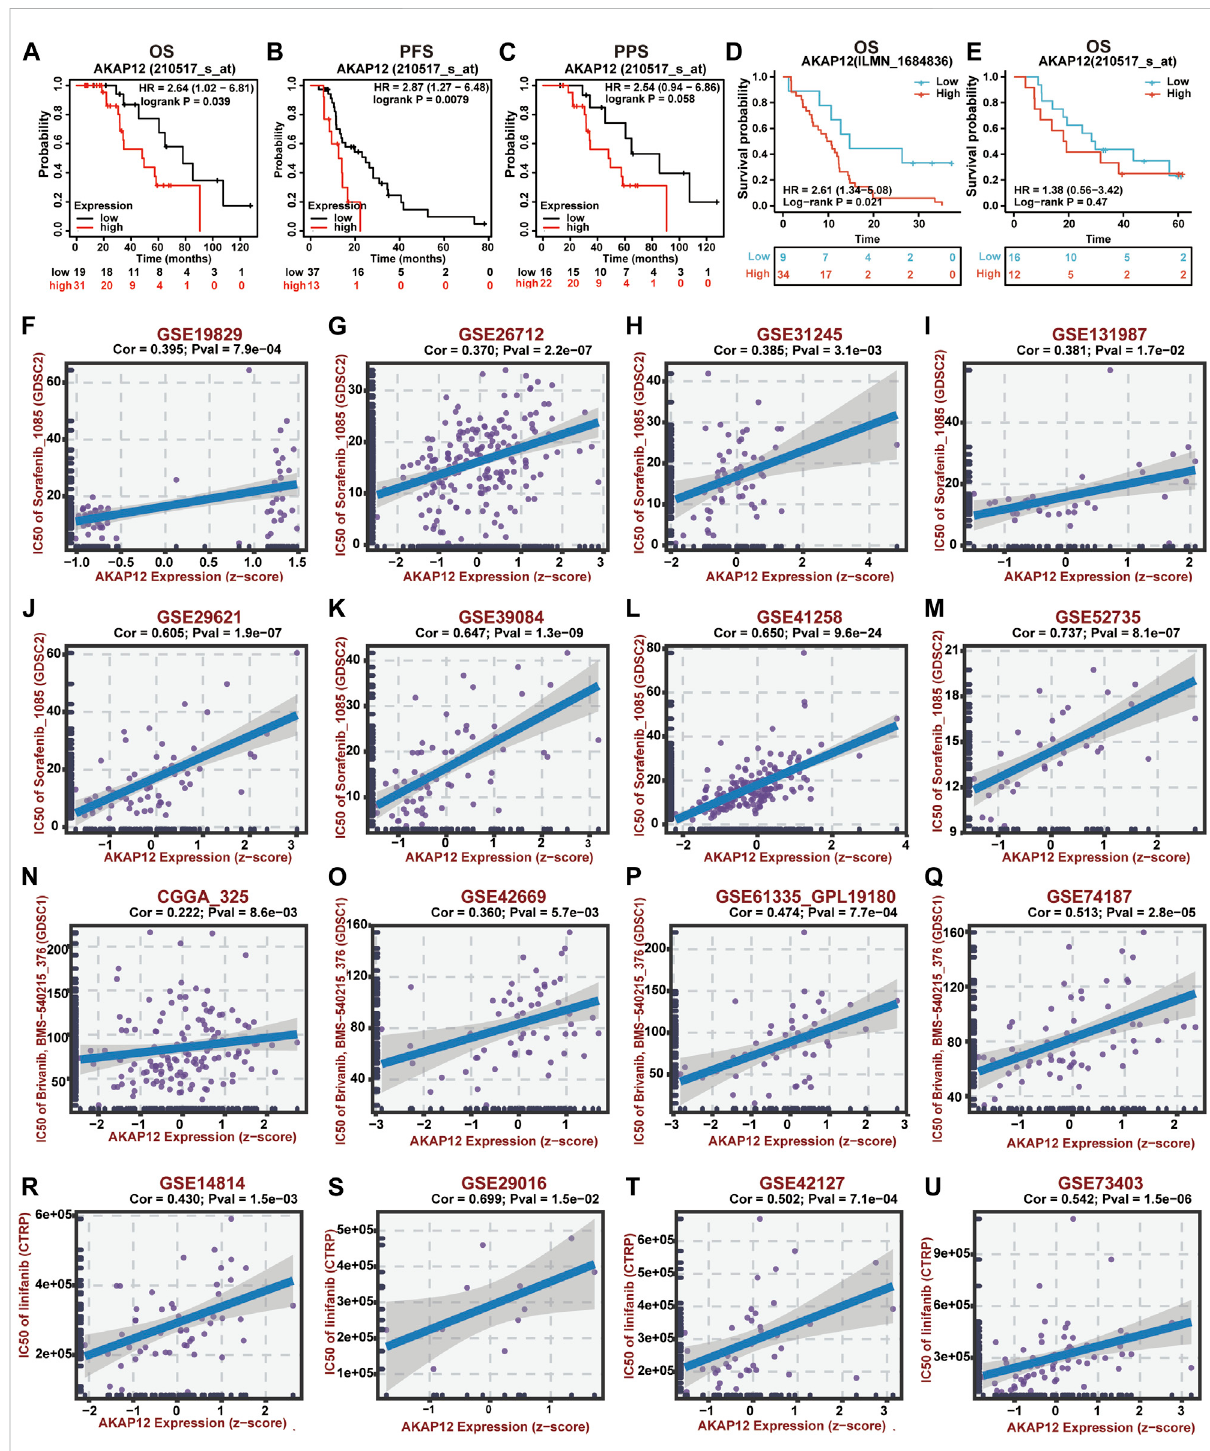
FIGURE 2 Prognosticvalue and drug sensitivity of AKAP12 in several cancers. The prognostic value of AKAP12 in OV patients (A – C) , GBM patients (D), and CRC patients (E) following BV treatment. OS, overall survival; PFS, progression-free survival; PPS, post-progression survival. Scatter plot of the association between AKAP12 expression and anti-VEGF therapy sensitivity of OV patients (F – I) , CRC patients (J – M) , GBM patients (N – Q) , and LUSC patients (R – U)